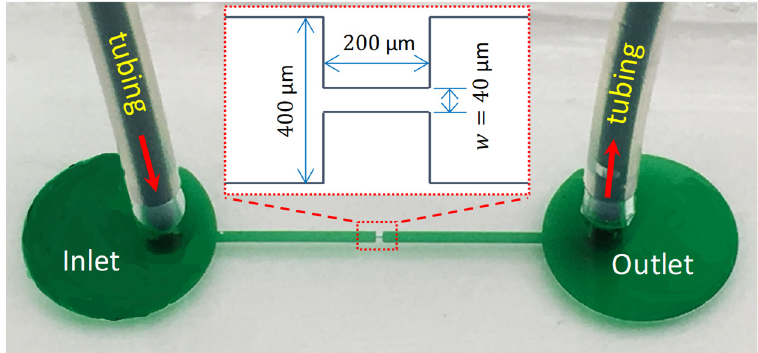
Figure 1. Picture of a fabricated 10:1:10 contraction- expansion microchannel with the inset displaying the dimensions. the